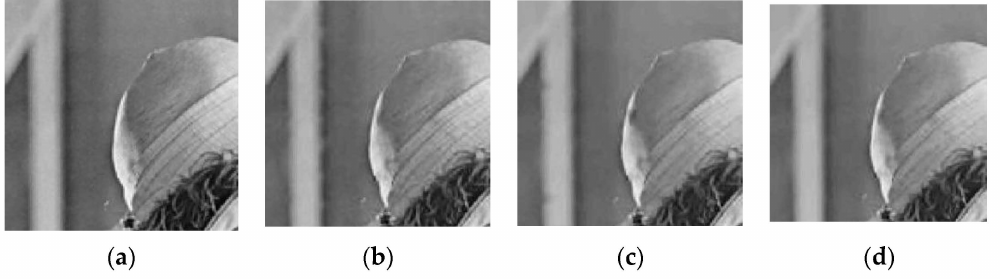
Figure 4. Zoomed portions of the original and reconstructed Lenna. ( a ) original image. ( b – d ) images reconstructed by TVL2, TVL0, and TVL1,